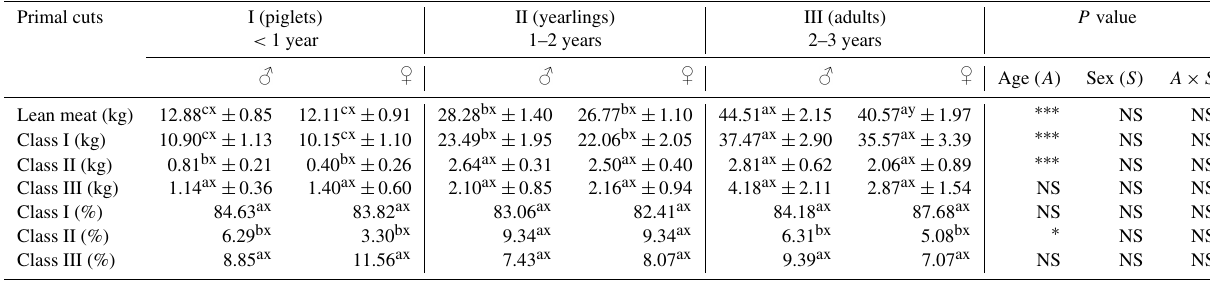
Table 4. Characteristics of wild boar meat in weight and percentage of lean meat (mean ± SE). Primal cuts